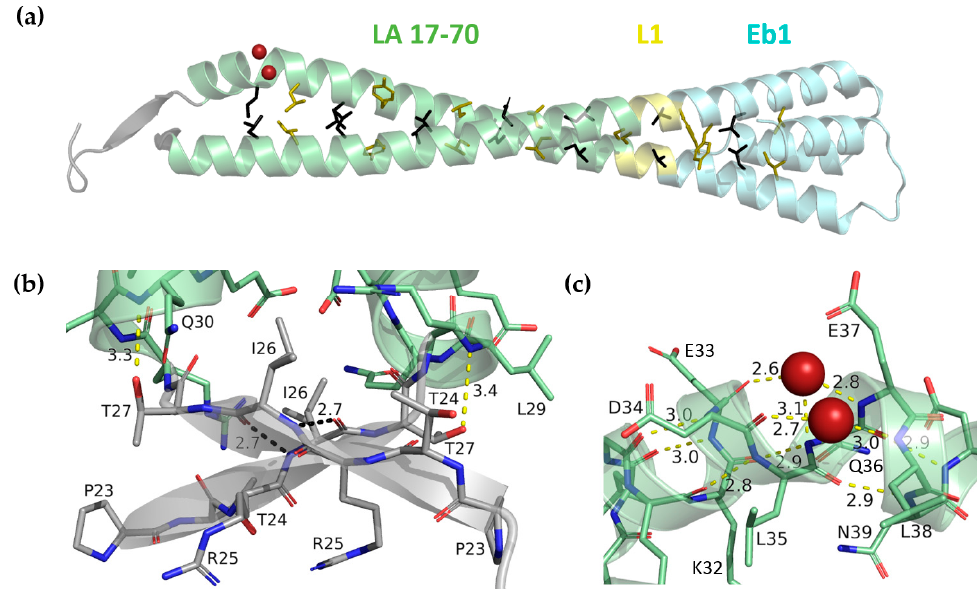
Figure 3. ( a ) Crystal structure of LA 17-70-Eb1. The head residues, coil1A and the first three residues of the linker L1 are coloured grey, pale green and yellow respectively. The Eb1 cap is coloured pale cyan. Two water molecules involved in H-bond bridges at the α -helical kink are shown as red spheres. Side chains of residues in ‘a’ (coloured black) and ‘d’ (coloured olive) positions starting with Leu35 i.e., the residues forming the hydrophobic core of the CC are shown as sticks. ( b ) Top view of the N-terminal end of the dimer featuring an antiparallel β -lock stabilized by two H-bonds (cyan dashed lines) between Ile26 residues. The H-bond between the side-chain oxygen of Thr27 and the main-chain nitrogen of Gln30 is shown (yellow dashed line). ( c ) Zoom in on the α -helical kink present in chain A. Regular main-chain hydrogen bonding pattern as well as two water-based H-bonding bridges are shown (yellow dashed lines). The suboptimal angular position of the H-bond between the main-chain oxygen of residue Lys32 and the nitrogen of residue Gln36 is shown as a purple dashed line.